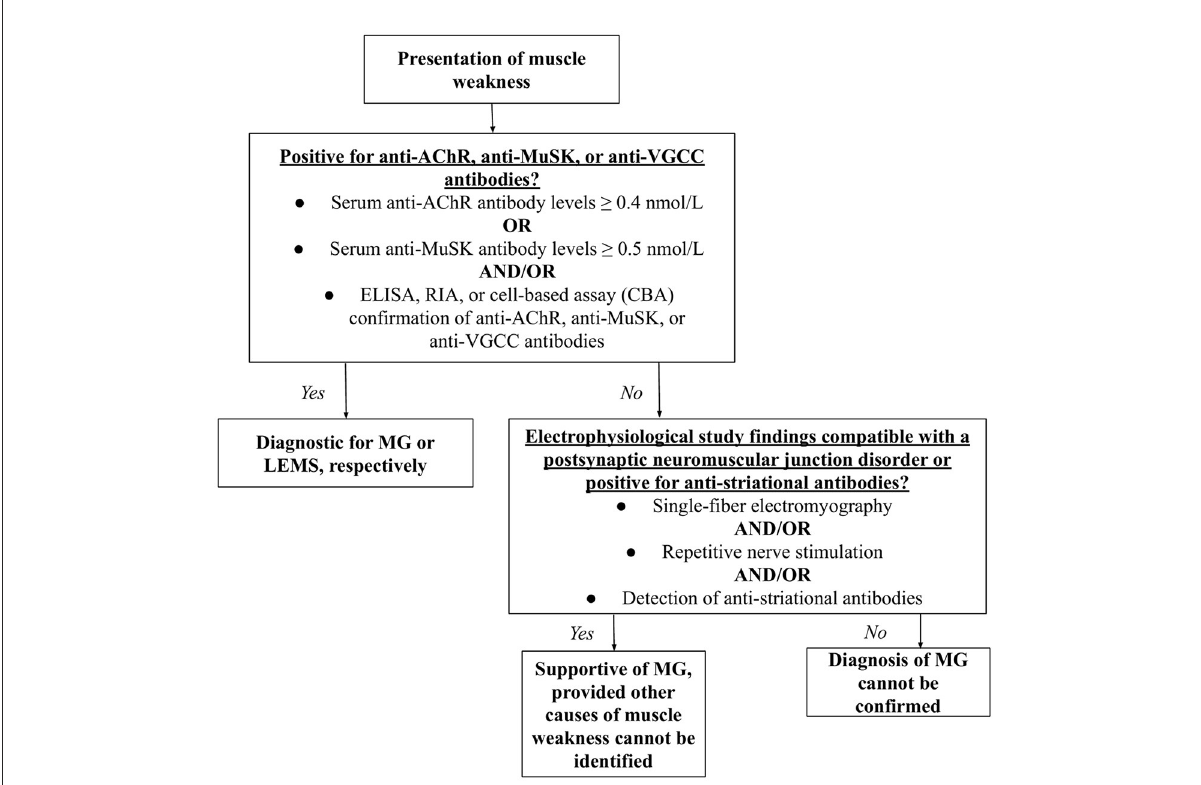
FIGURE2 Diagnostic algorithm for MG and LEMS. Having presented with muscle weakness, the patient would be tested for AChR, anti-MuSK, or anti-VGCC antibodies. Detectable levels of such antibodies are diagnostic for MG and LEMS, respectively. If levels of these antibodies are not detectable, single-fiber electromyography, repetitive nerve stimulation, and/or the detection of anti-striational antibodies would support a diagnosis MG, but not